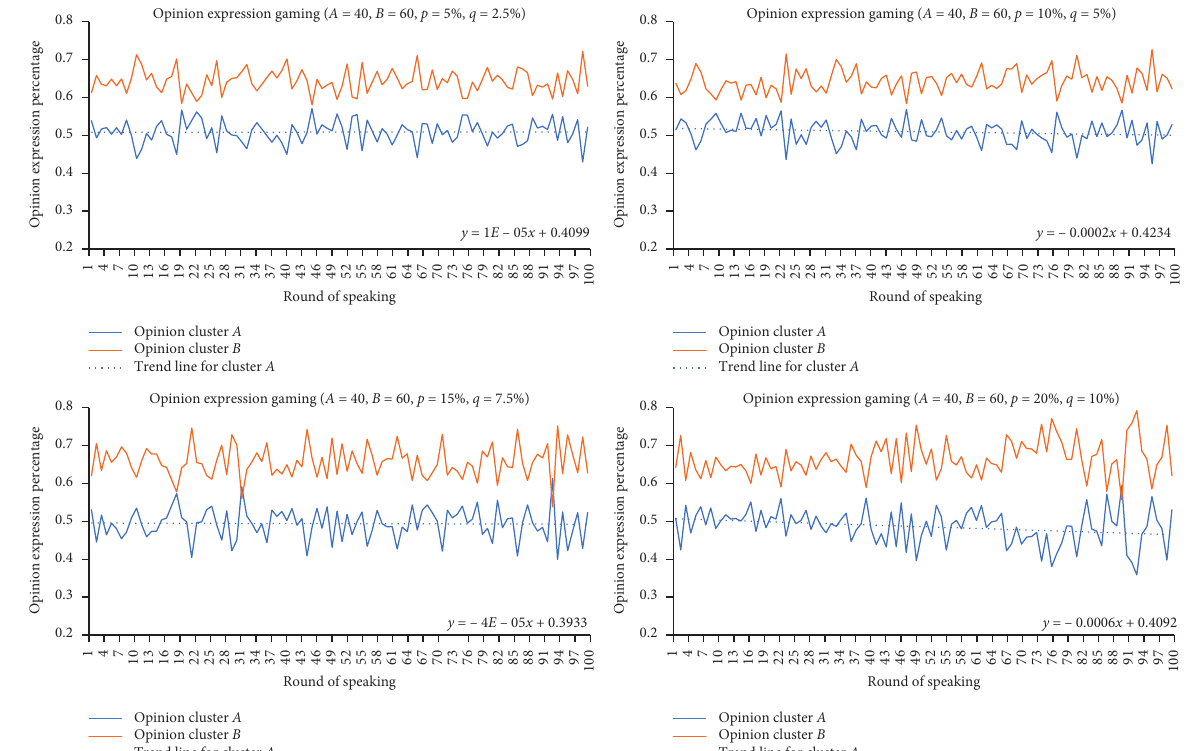
Figure 5: Minority/majority opinion expression. (For example, A � 40, B � 60). Note. Opinion expression percentage, with A (minority cluster) � blue thick line and B (majority cluster) � red thin line. Round of speaking represents time because each discussion allows 100 rounds of speaking. All the results were shown in the average score of 100 times’